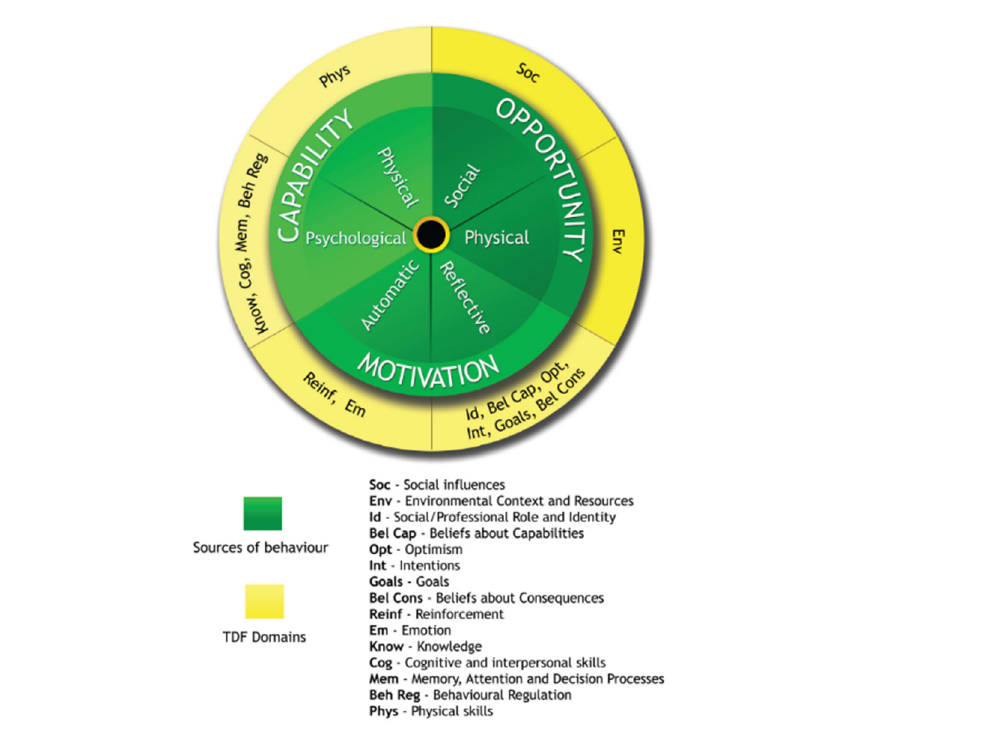
Figure 1. Map of Theoretical Domains Framework (TDF) to source behaviour on COM-B model [44].